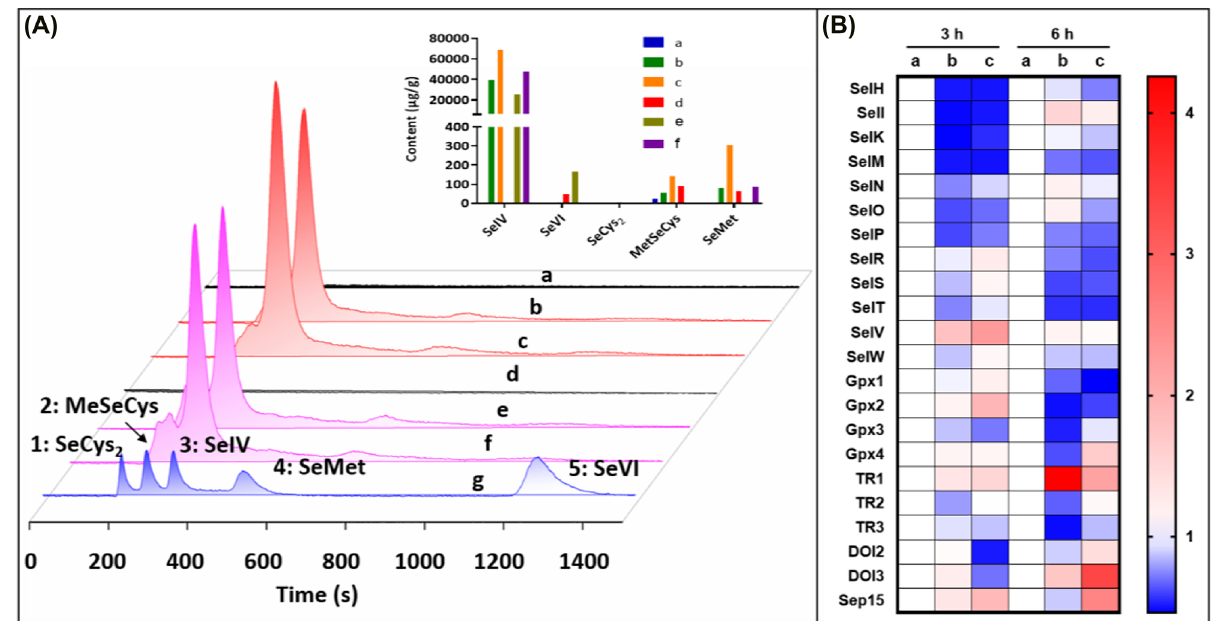
Figure 6: TW80-SeNPs metabolism in MG63 cells. , MeSeCys, and SeMet in MG63 cells 12 h and 24 h after treatment using HPLC-ICP-MS (A) Se metabolites including SeIV, SeVI, SeCys 2 analysis. The protein extraction solution of (a) MG63 cells for 12 h; (b) MG63 cells after TW80-SeNPs treatment for 12 h; (c) MG63 cells after TW80-SeNPs + met treatment for 12 h; (d) MG63 cells for 24 h; (e) MG63 cells after TW80-SeNPs treatment for 24 h; (f) MG63 cells after TW80-SeNPs + met treatment for 24 h. (g) Standard sample. (B) MG63 cells treatment with TW80-SeNPs and TW80-SeNPs + met examined by qPCR. The internal reference gene was GAPDH. The RNA extraction solution of (a) MG63 cells; (b) MG63 cells treatment with TW80-SeNPs; (c) MG63 cells treatment with TW80-SeNPs +